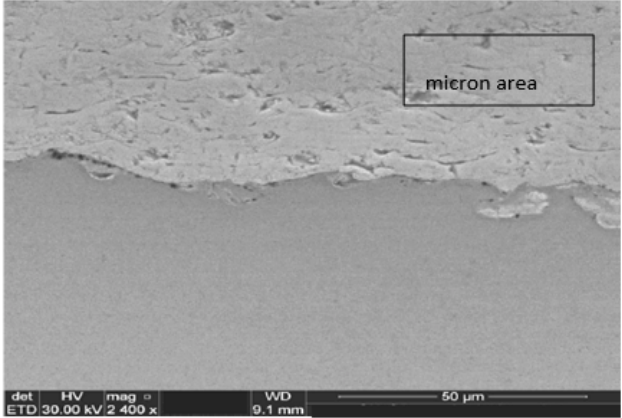
Figure11. The aspect of the Ni20Cr10Al2Y coating deposition .